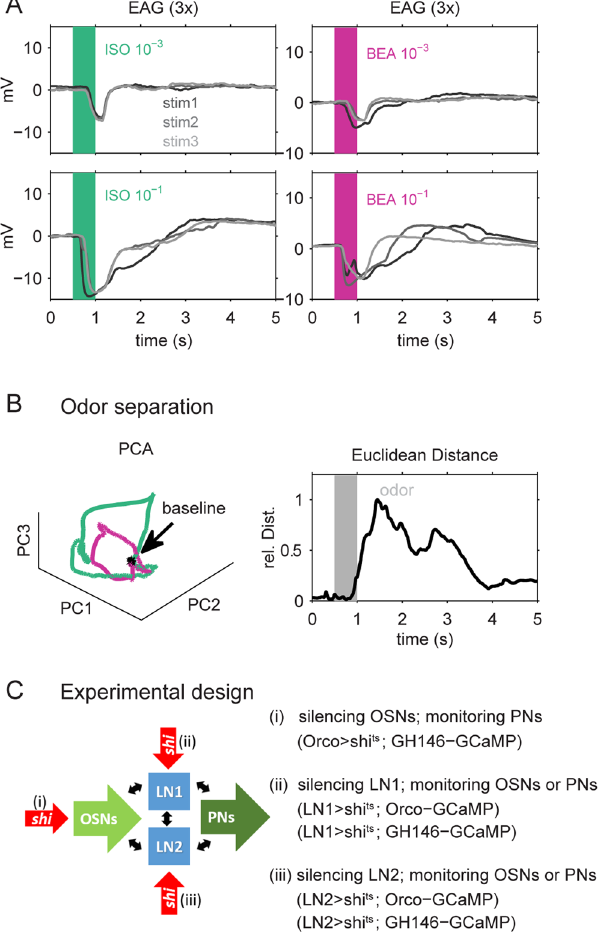
Figure 1. Odors can be separated based on electro-antennogramm (EAG) responses. The two odors isoamylacetate (ISO, green) and benzaldehyde (BEA, violet) can be well separated at the level of the sensillum- population activity. ( A ) EAG responses during application of ISO and BEA. Each odor stimulus is repeated three times (steps of grey) at a low (0.001 vol/vol; upper two panels) and high concentration (0.1 vol/vol; lower two panels). The odor stimulation (500 ms) is indicated by colored bars in each panel. All stimuli evoked a reliable and reproducible EAG response reflecting naturally stimulation conditions in the antennal working range. ( B ) The three stimulus repetitions in 10 animals were used to create a population vector (cp. Methods). Principal component analysis of these vectors (left) illustrate that ISO (green) and BEA (violet) induced distinct trajectories during odor application. The black dot refers to the baseline activity before odor onset. The separation of both odors could be verified by their Euclidean distances (right). ( C ) Experimental design: We used two binary transcription systems (LexA-LexAop and GAL4-UAS) to selectively express a temperature- sensitive form of shibire ( shi ts ) to silence one specific type of neuronal population, while we expressed the calcium sensor GCaMP in neurons that we aimed to monitor. First, we expressed shi ts in olfactory sensory neurons (OSN) and GCaMP3.0 in projection neurons (PN) and established the necessary experimental conditions (i). In the next step we expressed shi ts in local interneurons type 1 (LN1) and monitored either the OSN or the PN activity, respectively (ii). Furthermore we expressed shi ts in local interneurons type 2 (LN2) and monitored again the OSN and the PN activity, respectively